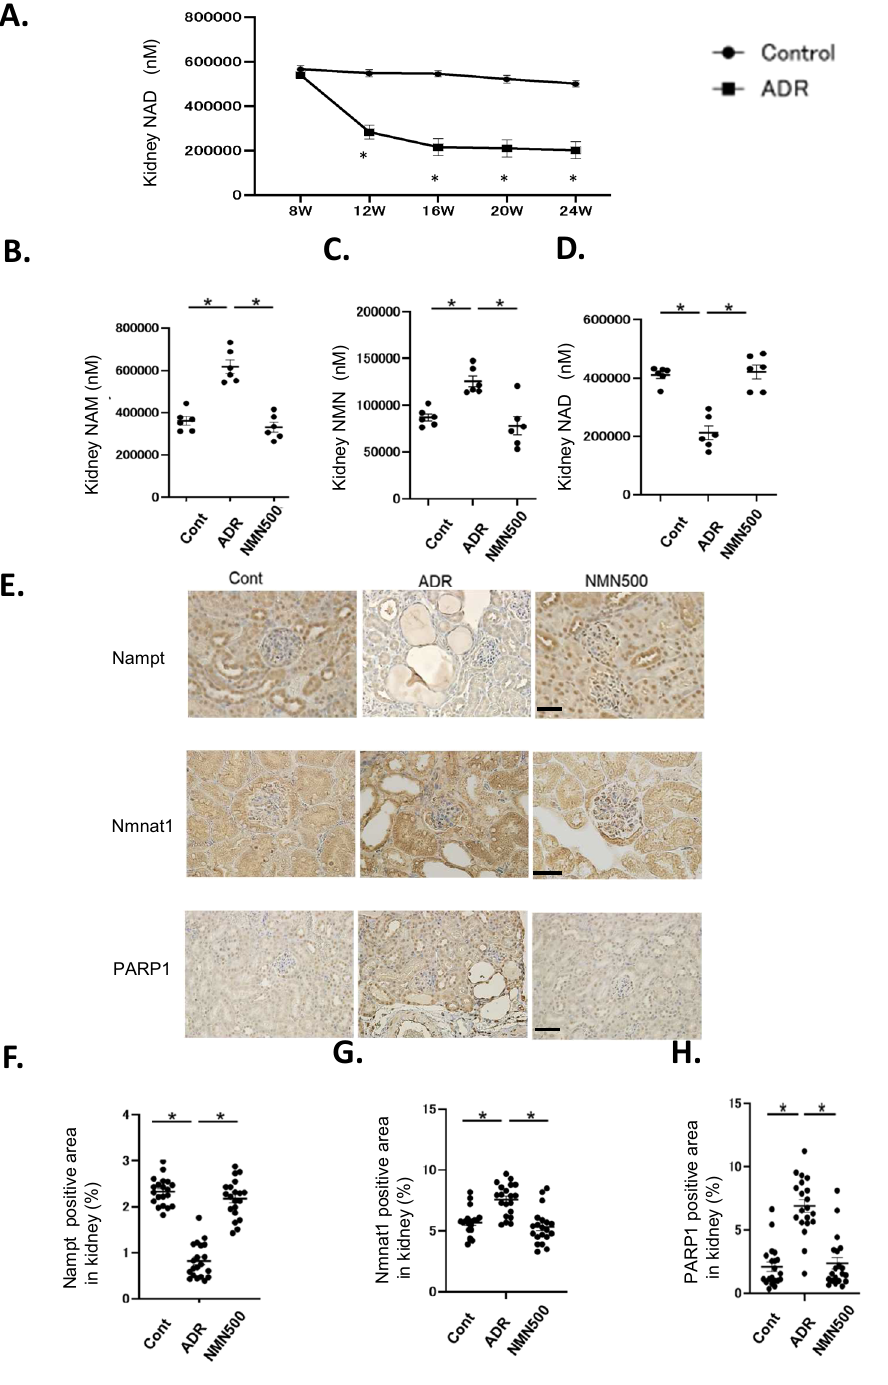
Figure 6. Effects of NMN treatment on NAD + metabolites and the salvage pathway. ( A ) Temporal changes in NAD + concentrations in the kidneys of mice in the Cont and ADR groups ( n = 6). ( B–D ) Renal tissue concentrations of NAD + metabolites, NAM ( B ), NMN ( C ), and NAD + ( D ) in the salvage pathway on day 28 in the Cont, ADR, and NMN500 groups ( n = 6). ( E ) Representative images of sections immunostained with Nampt, Nmnat1 in the kidneys of the Cont, ADR, and NMN500 groups (scale bar 50 µm). ( F–H ) Proportional staining areas for Nampt ( F ), Nmnat1 ( G ), and PARP1 ( H ) ( n = 20 sections/group). All data are shown as mean ± standard error of the mean. Statistical significance between each group is represented by a horizontal bar. * P <